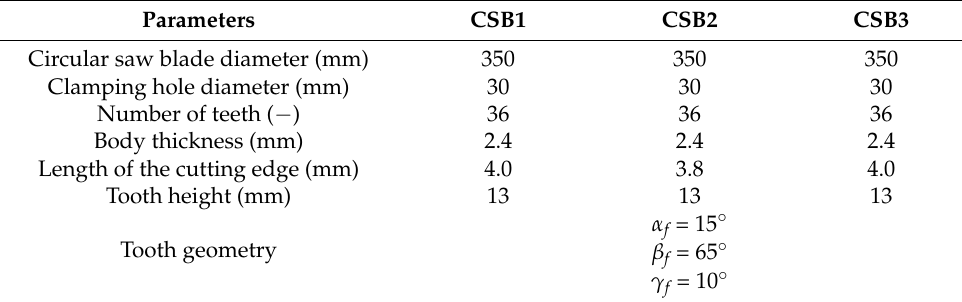
Table 1. The basic parameters of the used circular saw blades.